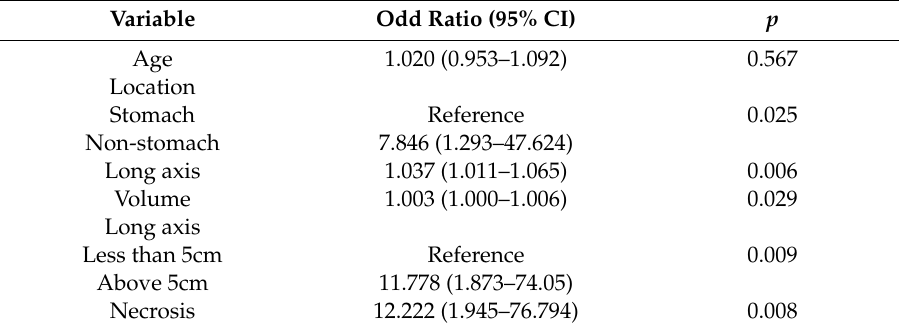
Table 3. Multivariate analysis of factors related to